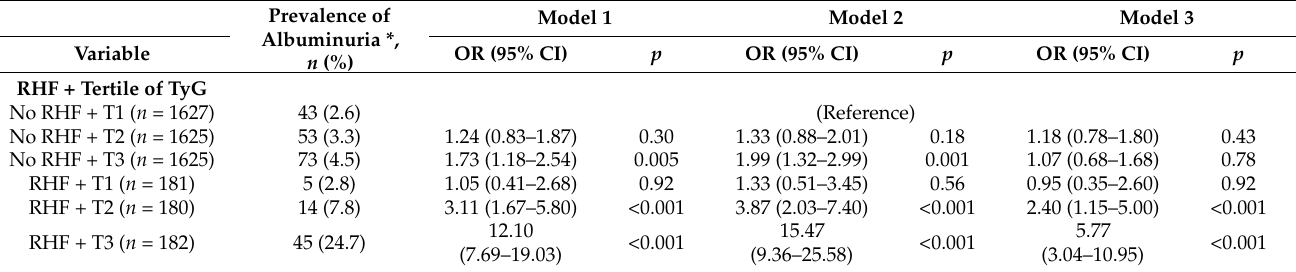
Table 5. Subgroup analysis stratified by the combination of RHF and TyG index.